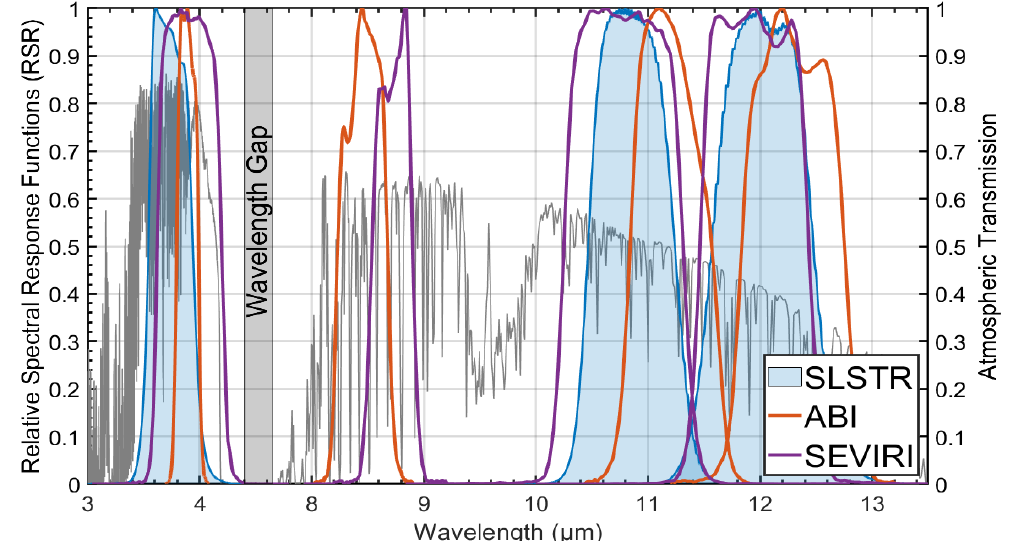
Figure 1. Relative spectral response function of the Sea and Land Surface Temperature Radiometer (SLSTR), with those of Advanced Baseline Imagers (ABI) and Spinning Enhanced Visible and Infrared Imager (SEVIRI) thermal bands around wavelengths of 3.7 μ m, 8.9 μ m, 11 μ m and 12 μ m. Data are from National Oceanic and Atmospheric Administration Center for Satellite Applications and Research (STAR) National Calibration Center for Visible Infrared Imaging Radiometer Suite (VIIRS)/ABI, from the European Space Agency (ESA )Sentinels Hub for SLSTR and SEVIRI. The gray line is the atmospheric transmission spectrum for vertical propagation through a standard atmosphere. Table 1. Spectral bands of the SLSTR and geostationary satellite radiometers ABI and SEVIRI. All these bands are usually referred to as thermal emissive bands. Only those with a sea surface temperature (SST) capability are shown.